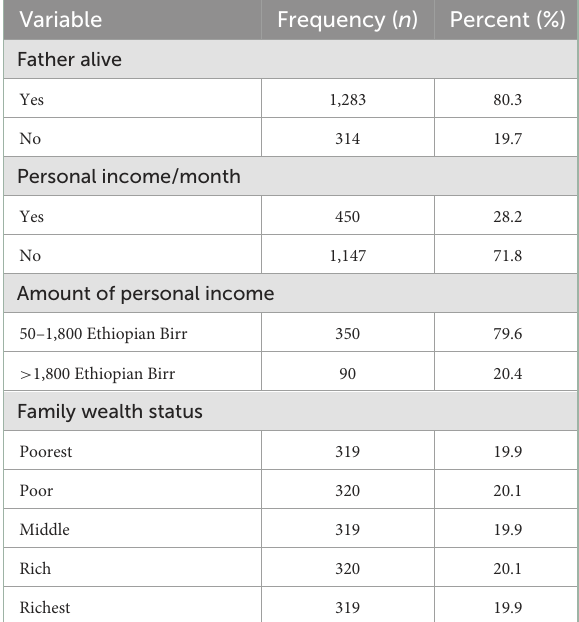
TABLE 1 Sociodemographic characteristics of youths living in the central, west, and north Gondar